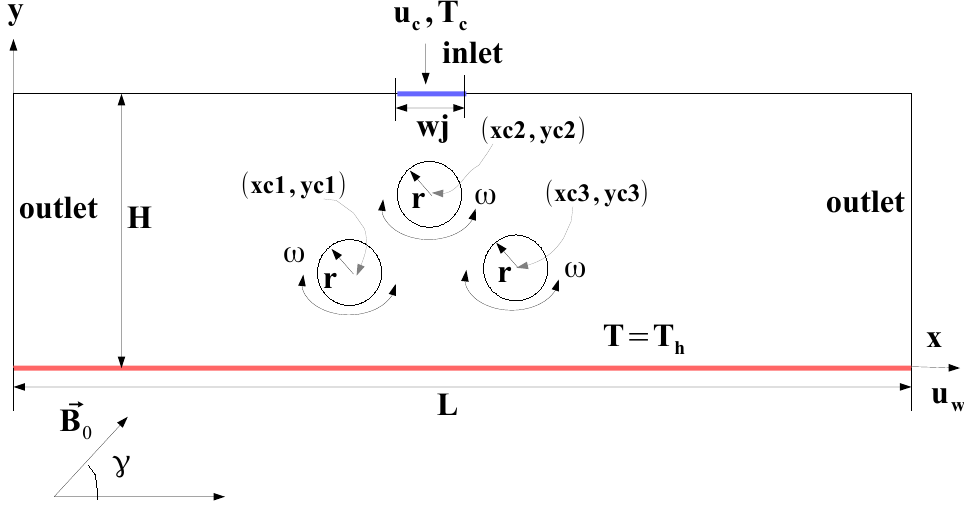
Figure 2. Schematic description of the SJ-I cooling system for a moving hot wall under combined effects of MGF and multiple rotating